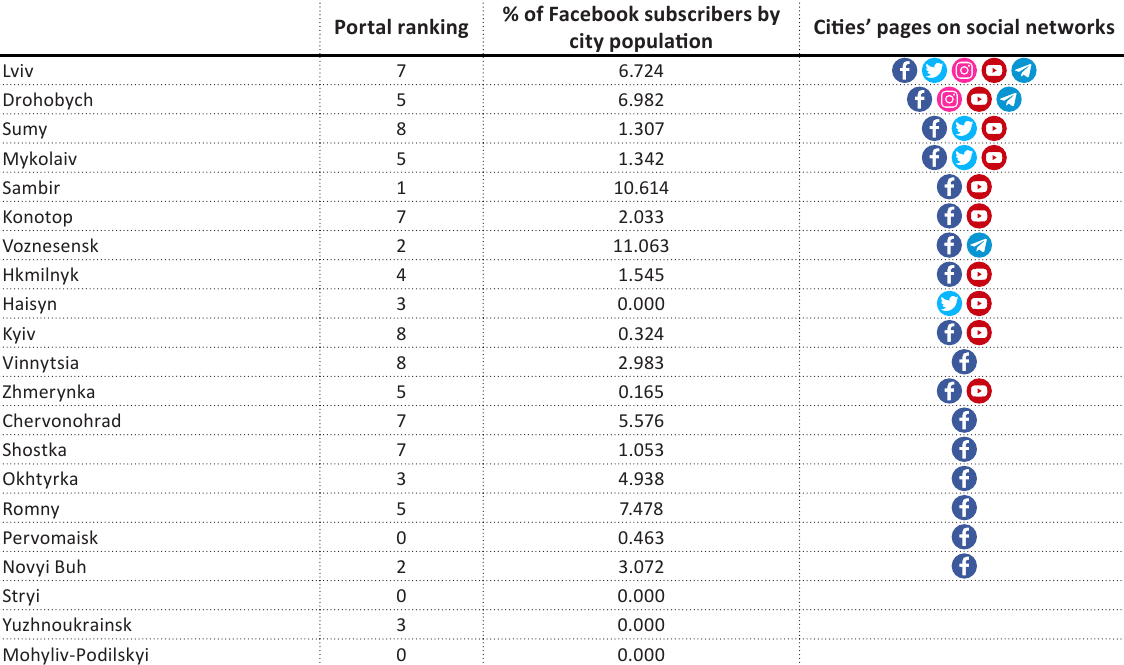
Table 2. Community involvement in the social networks of the cities under study